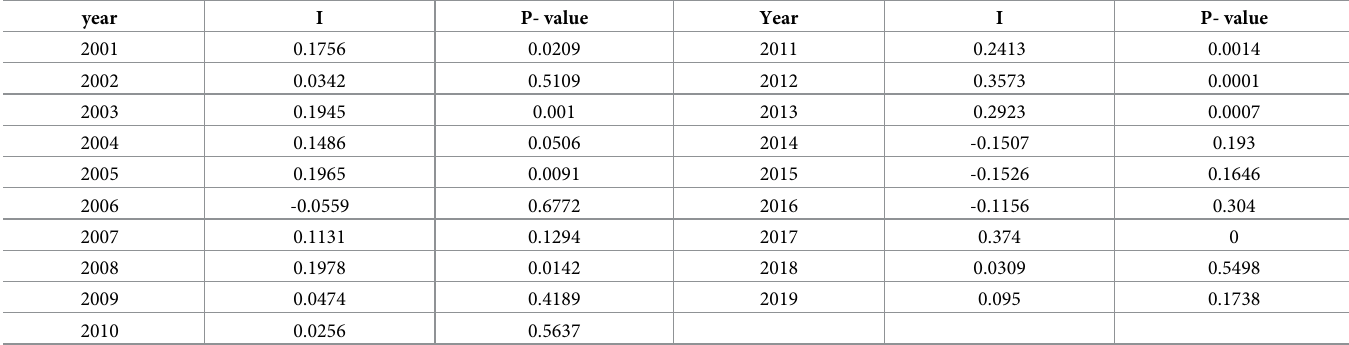
Table 4. Results of the global spatial correlation